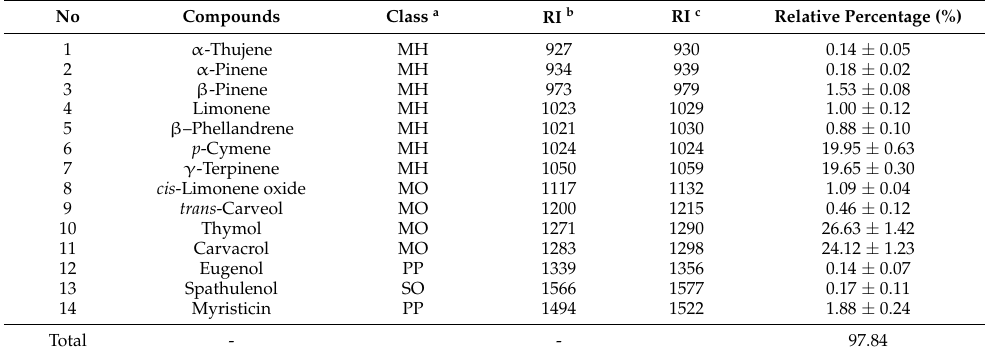
Table 1. The chemical composition of Oliveria decumbens Vent. Essential